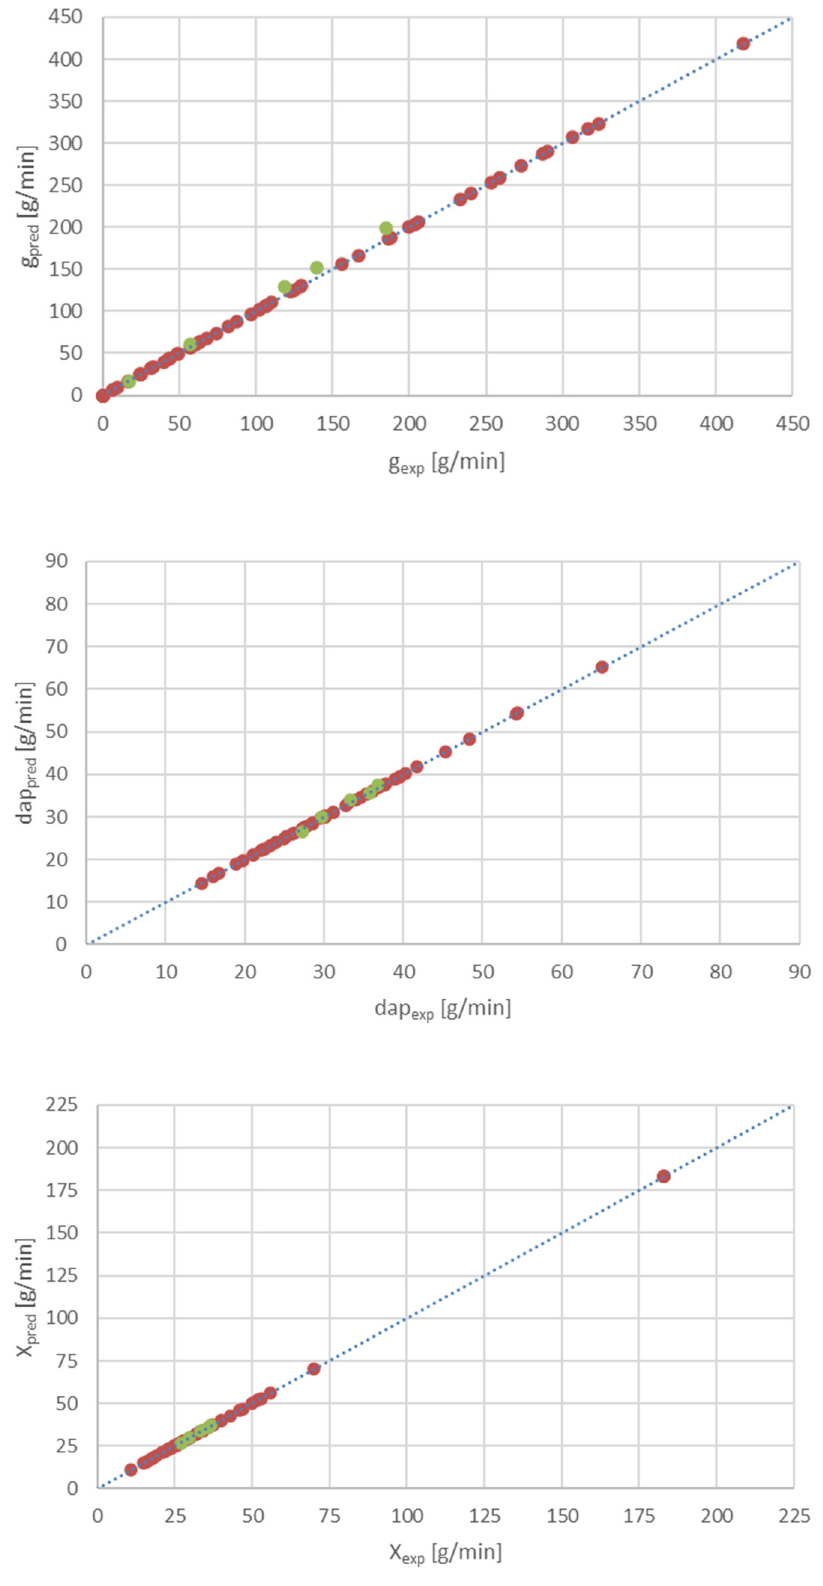
Figure 5. Comparison of desired g, d ap and X (measured, from experiment) that and predicted by FLClass model (brown symbols refer to data used to build the model, while green ones apply to a new testing data set, previously unseen by the system).